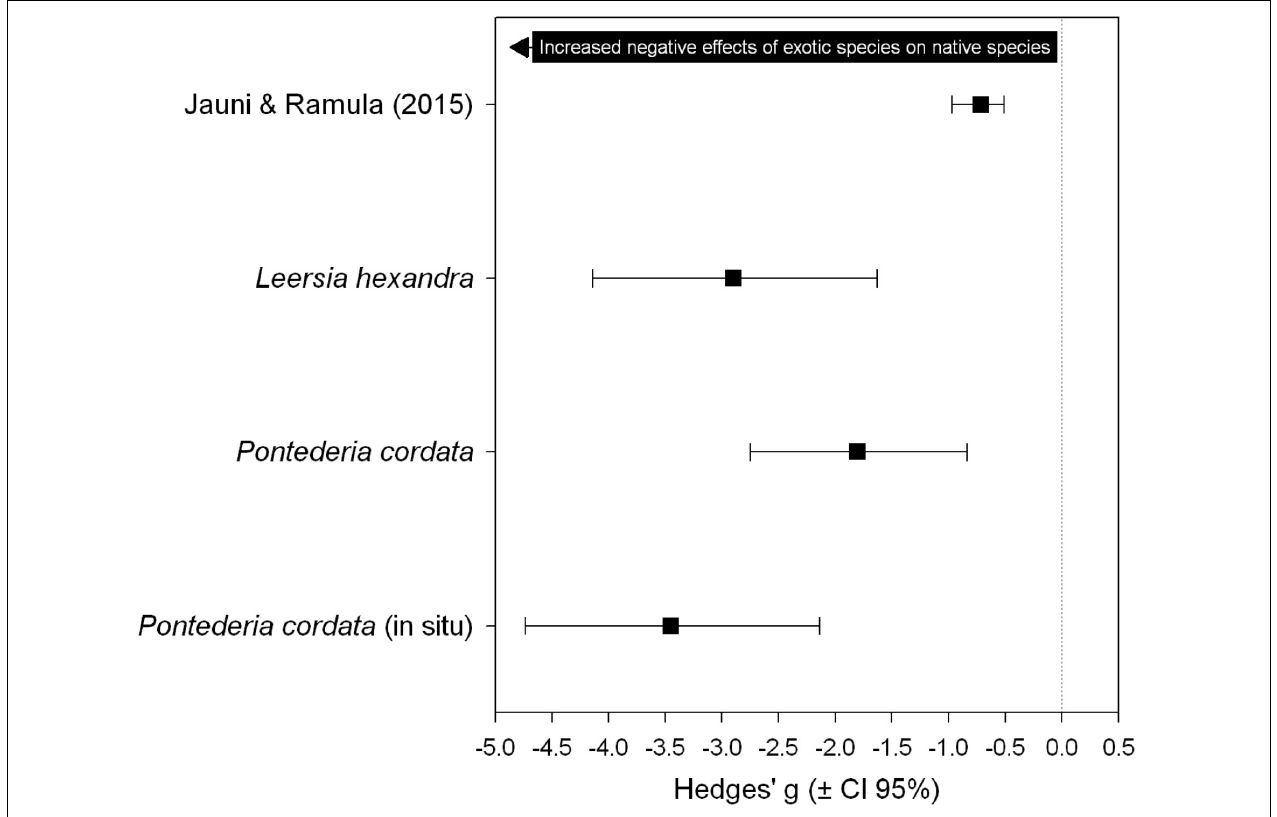
FIGURE 3 | Cumulative effect size estimated by Jauni and Ramula (2015) and effect sizes estimated in this study. These assess the effects of invasive exotic plants on the biomass of native